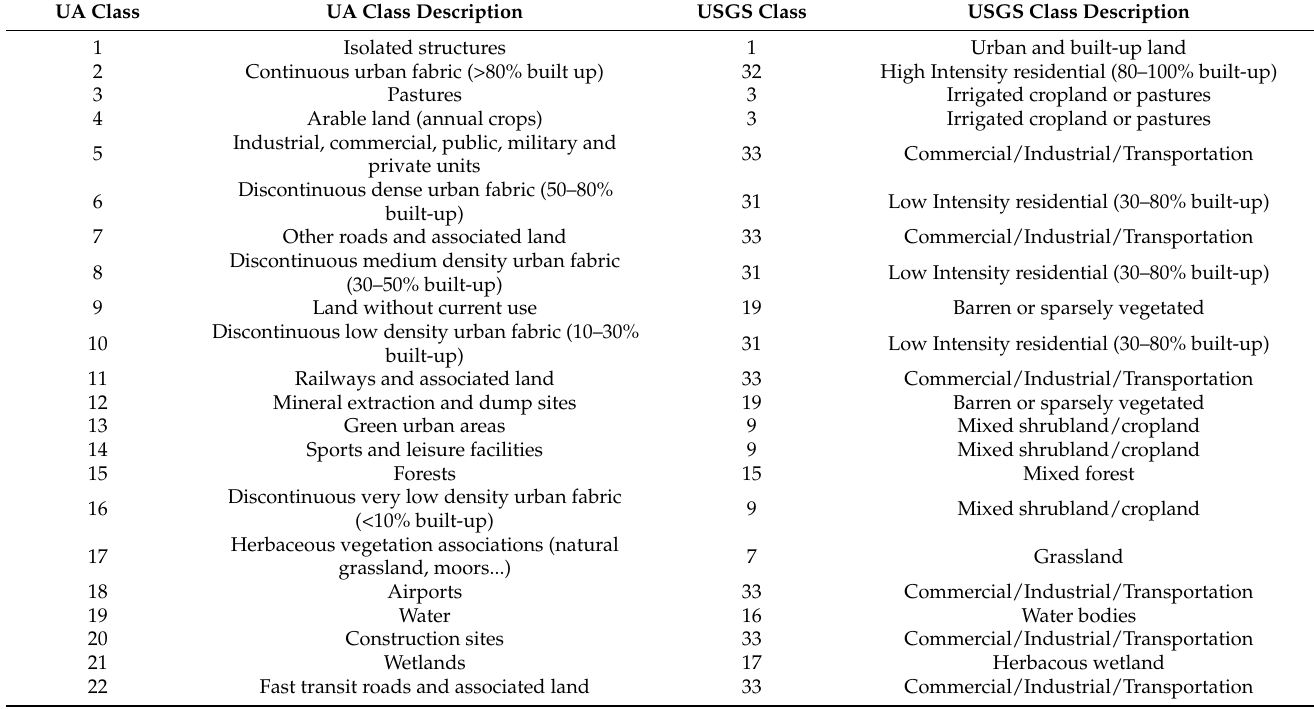
Table A1. Reclassification of Urban Atlas (UA) classes to United States Geological Survey (USGS)